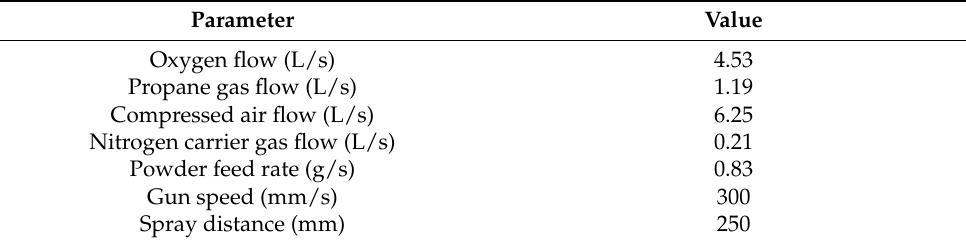
Table 2. The optimized HVOF spray